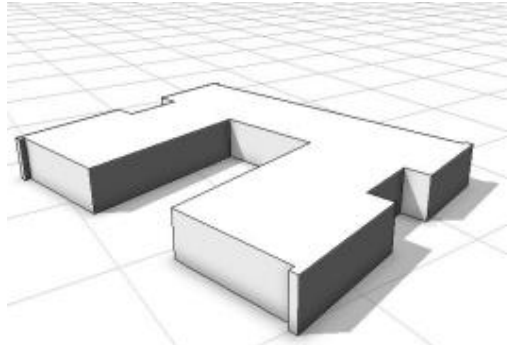
Figure 11: The extruded model of the building with separated Figure 13: The final building model surfaces At this point the Object attributes of both the window and the door, are enriched, as previously done for the wall surfaces, the roof and the ground floor, as shown in figure